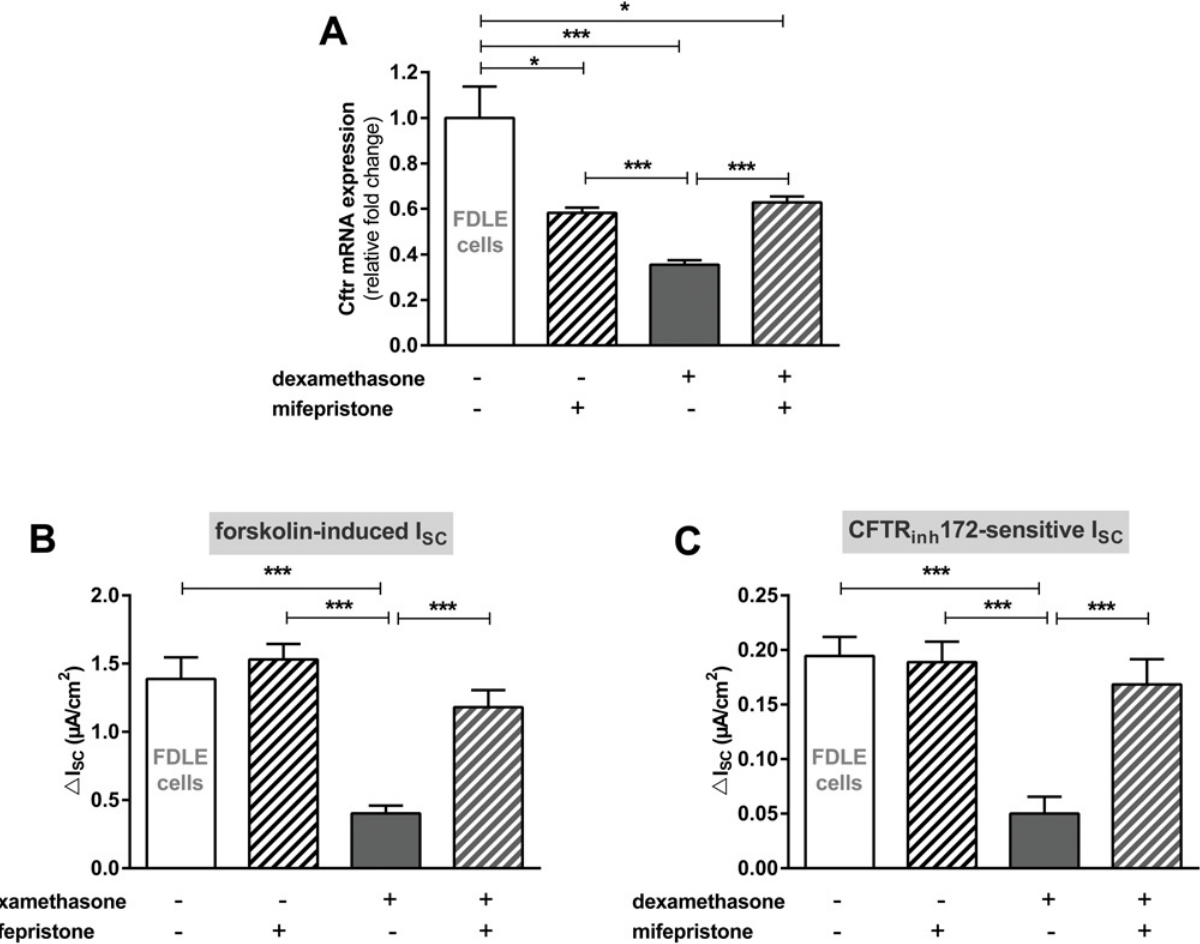
Fig 4. Mifepristone restores Cftr mRNA expression and channel activity in the presence of dexamethasone in FDLE cells. A: Graph represents the mean + SEM for normalized Cftr mRNA expression in response to 100 nM dexamethasone and mifepristone for 24 h acquired by RT-qPCR (n = 4, * p < 0.05, *** p < 0.001, ANOVA with Tukey's post hoc test). B/C: Graphs represent the mean + SEM of I SC in response to 100 nM dexamethasone and mifepristone for 24 h measured in Ussing chambers. B: Forskolin-induced I SC (n = 10 – 17, *** p < 0.001, ANOVA with Tukey's post hoc test). C: CFTR inh 172-sensitive I SC (n = 8 – 13, *** p < 0.001, ANOVA with Tukey's post hoc